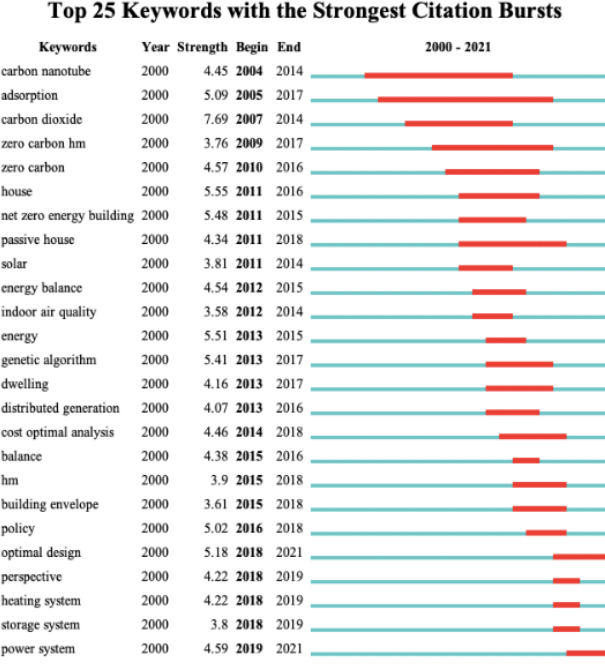
Figure 5. Keywords sorted by emergence time.